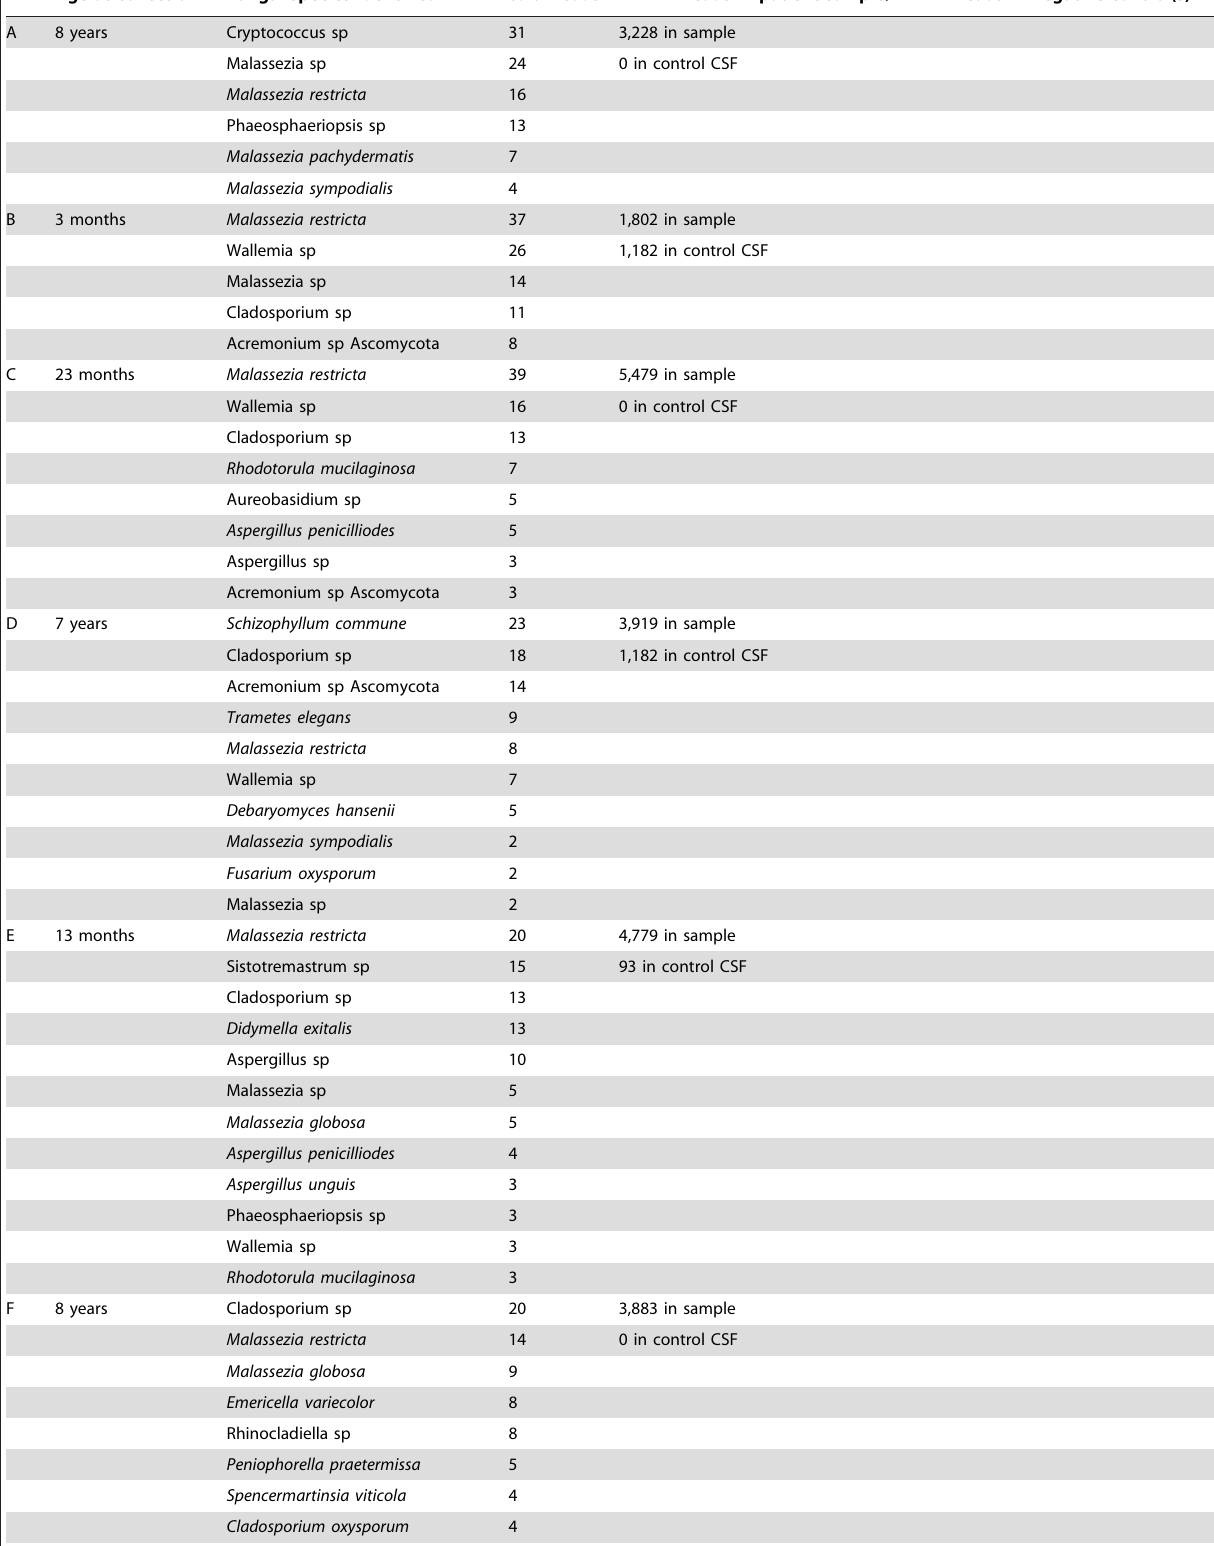
Age at collection Fungal species